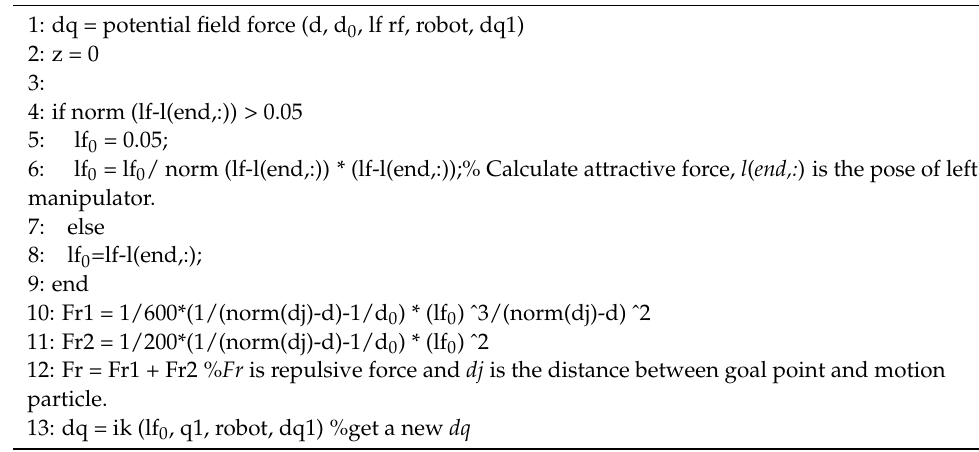
Algorithm 2. Calculation of joint potential field